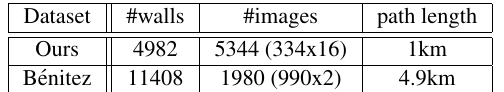
Table 1: Comparison between our dataset and the dataset of B´enitez.